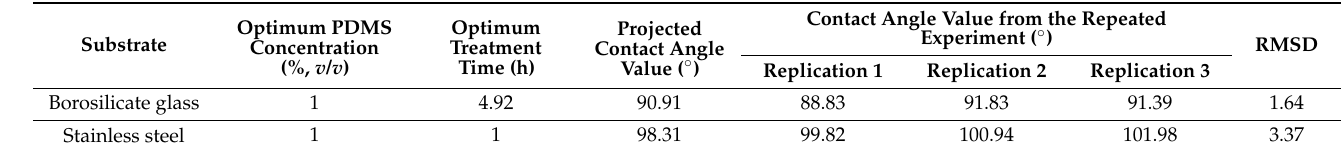
Table 6. Comparison of the expected contact angle readings of the borosilicate glass and stainless steel surfaces with the actual contact angle measured in repeated trials with optimum parameters to determine the model